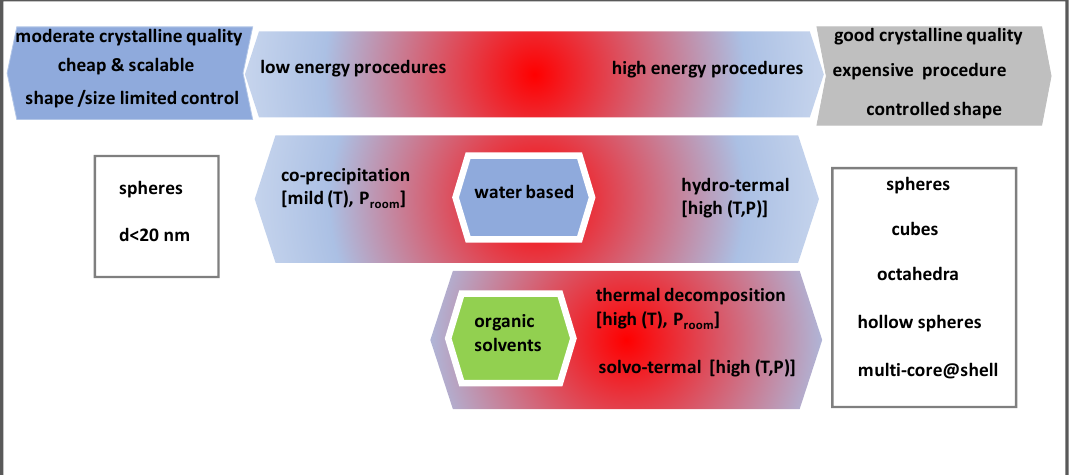
Figure 4. Summary of synthetic routes commonly used to produce superparamagnetic iron oxides nanoparticles (SPIONs).